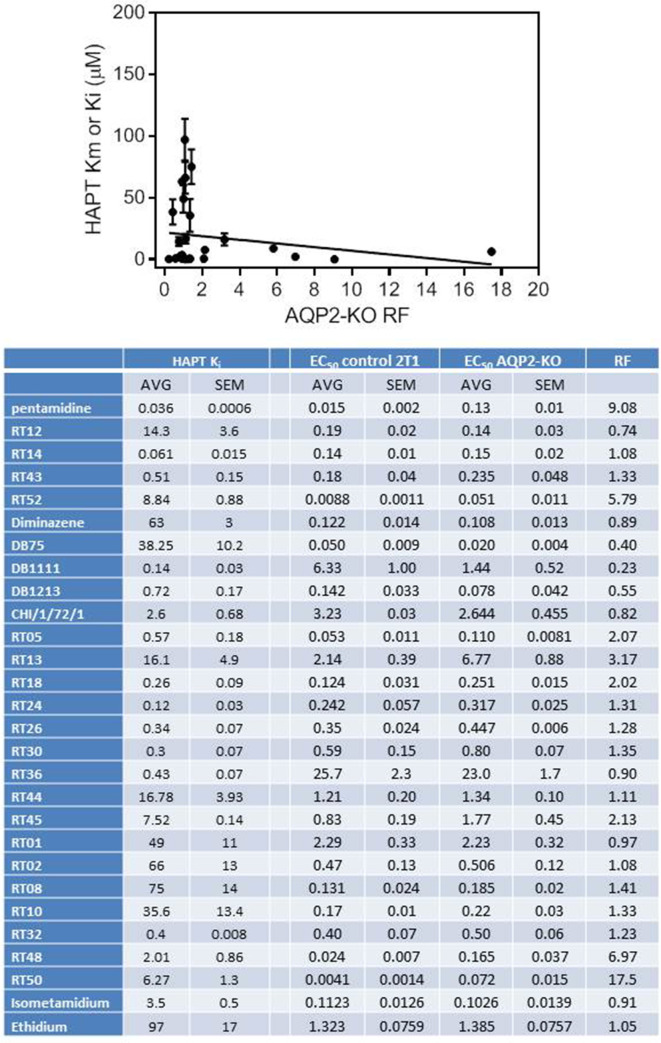
Correlation between the Resistance Factor (RF; EC50(aqp2/3 null)/EC50(TbAQP2-WT)) and the Ki value for inhibition of the High Affinity Pentamidine Transporter (HAPT1) encoded by TbAQP2.The pentamidine value (bold) is the Km determined with radiolabeled pentamidine. The table lists the data points shown in the plot. The line was made by linear regression (Prism 6.0); correlation coefficient r2 is 0.037. F-test: slope is not significantly different from zero (p=0.33). All values are in µM. All data for these graphs are contained in Figure 9—source data 1.